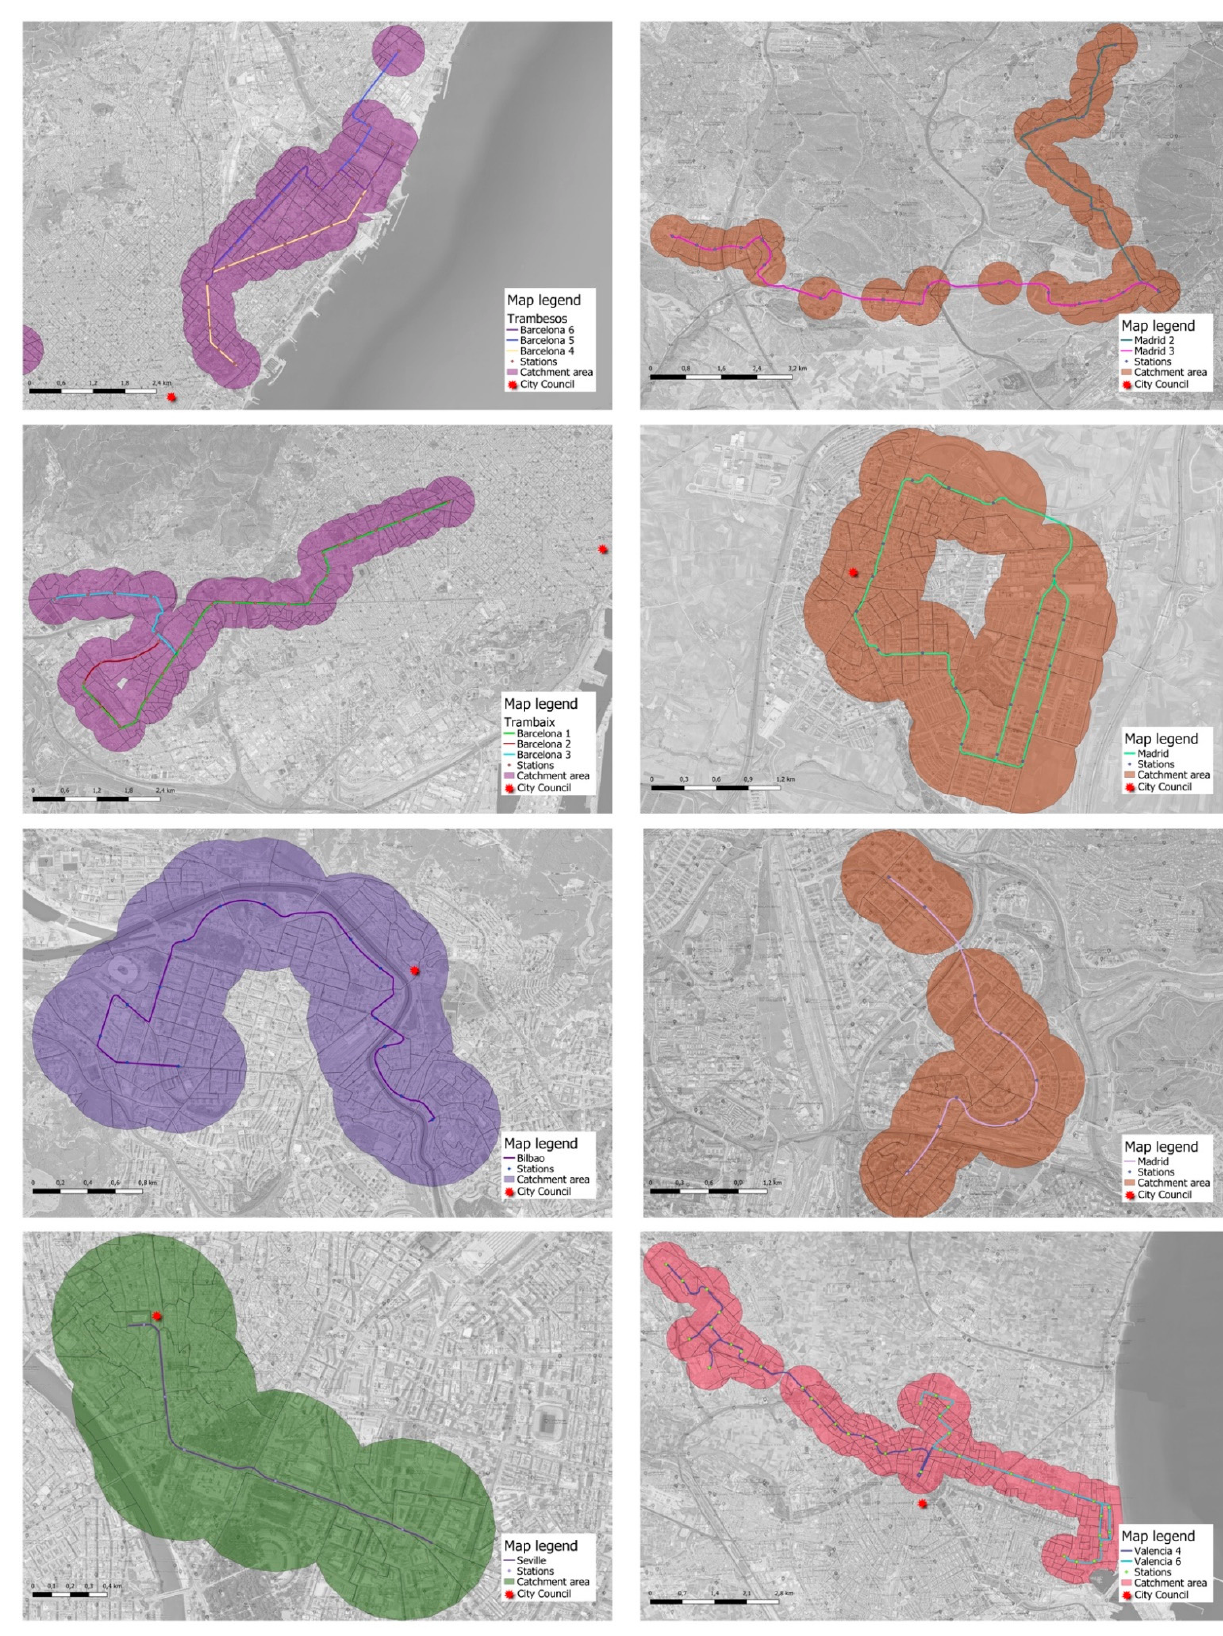
Figure 4. Cities in Group 2. Left-hand column: Barcelona; Barcelona; Bilbao; Seville. Right-hand column: Madrid, Madrid, Madrid; Valencia.